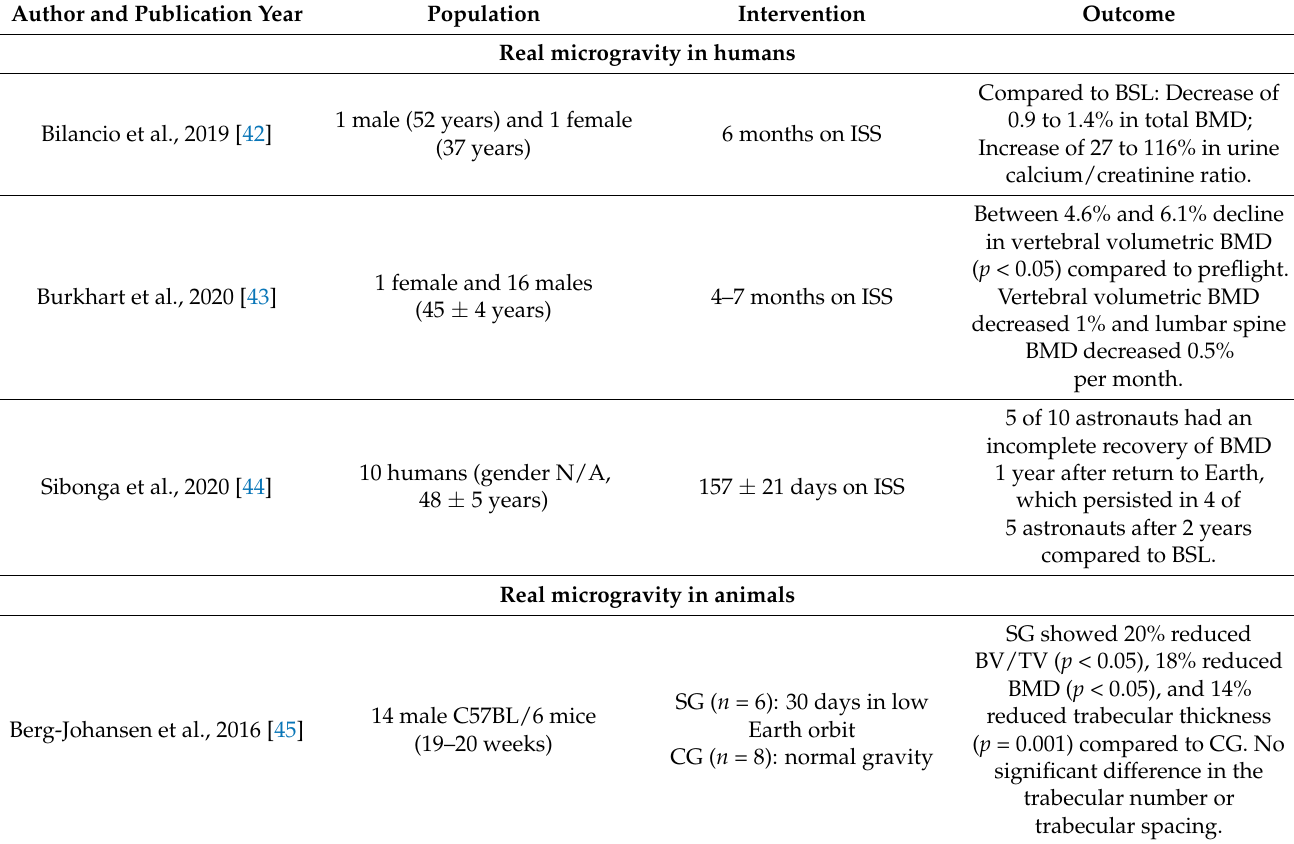
Table 1. The mechanisms of µ g -related changes in bone